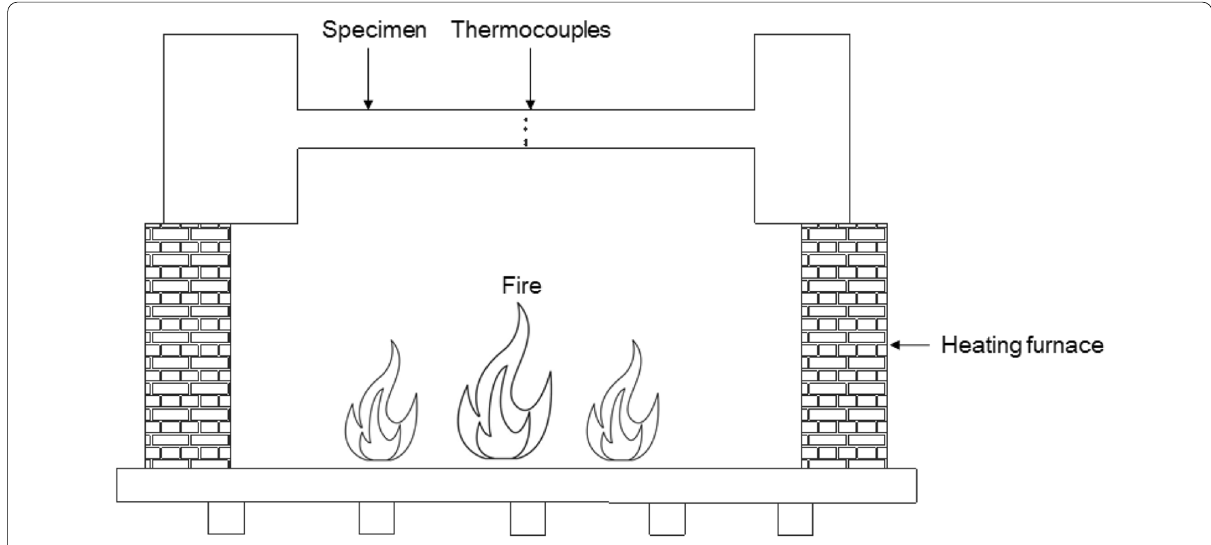
Fig. 2 Specimen set-up for fire